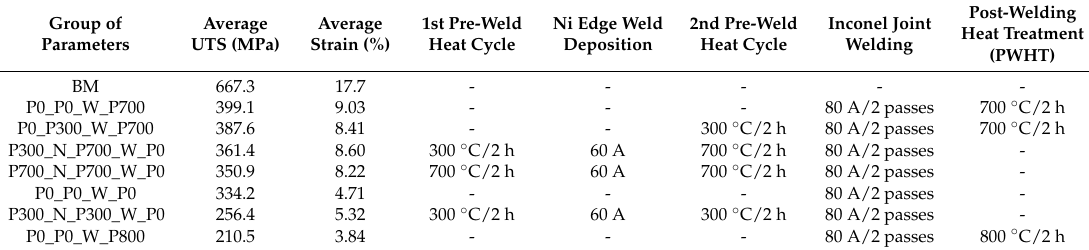
Table 6. Comparison between test results and heat treatment methodologies. Group of Average Average Parameters UTS (MPa) Strain